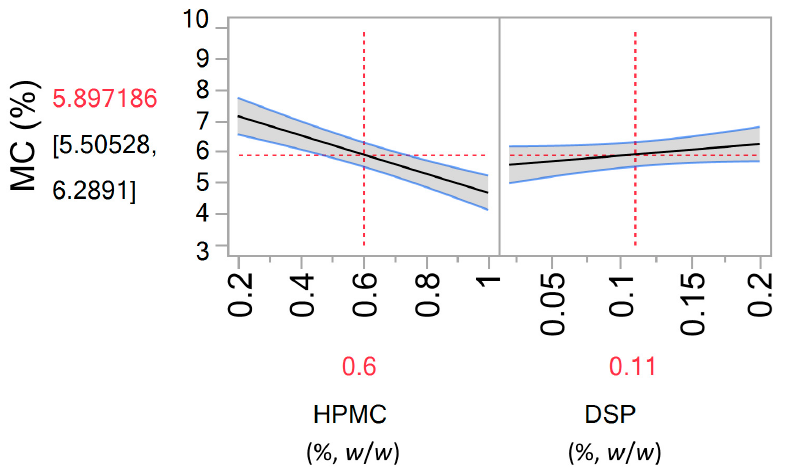
Figure 3. Prediction of moisture content (MC) in relation to hypromellose (HPMC) and DSP concentrations. Values in brackets refer to 95% confidence interval.